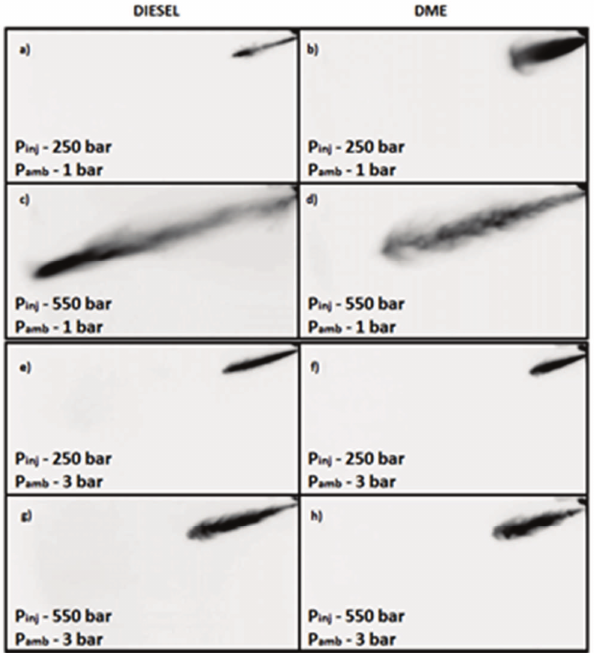
Fig. 4. Comparison of the atomization of DME and diesel fuel under different injection conditions